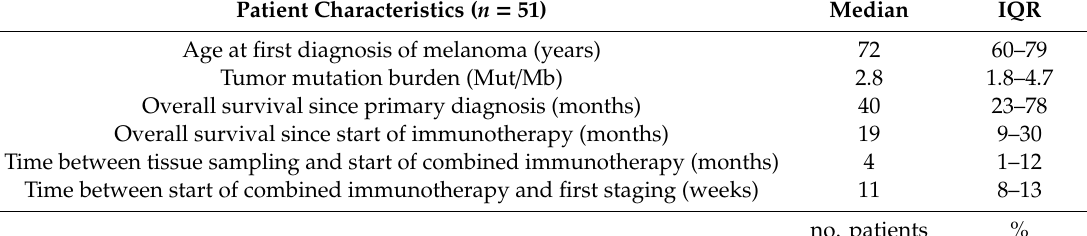
Table 1. Patient